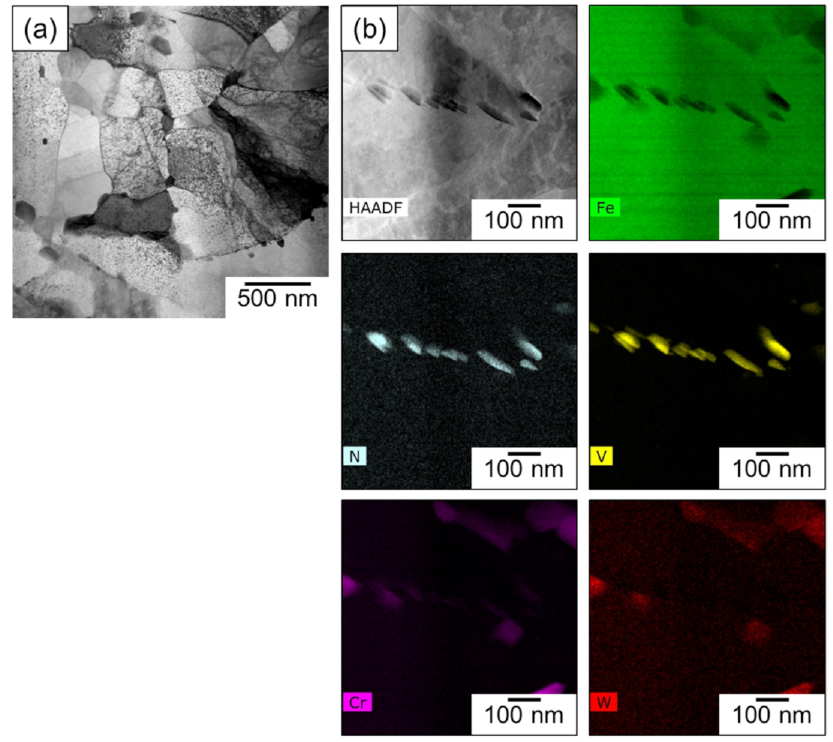
Figure 15. HAADF image of the microstructure after HT-2 ( a ). STEM EDS micrographs of area ( b ) are showing the presence of both M 23 C 6 and MX carbides after PPHT